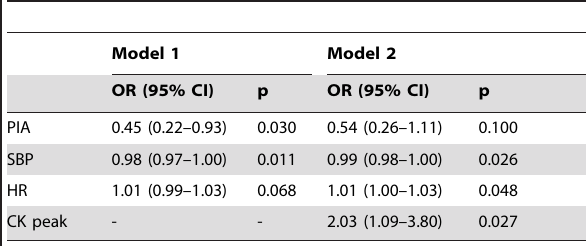
Table 3. Multivariate analysis for predictors of in-hospital ventricular arrhythmias.